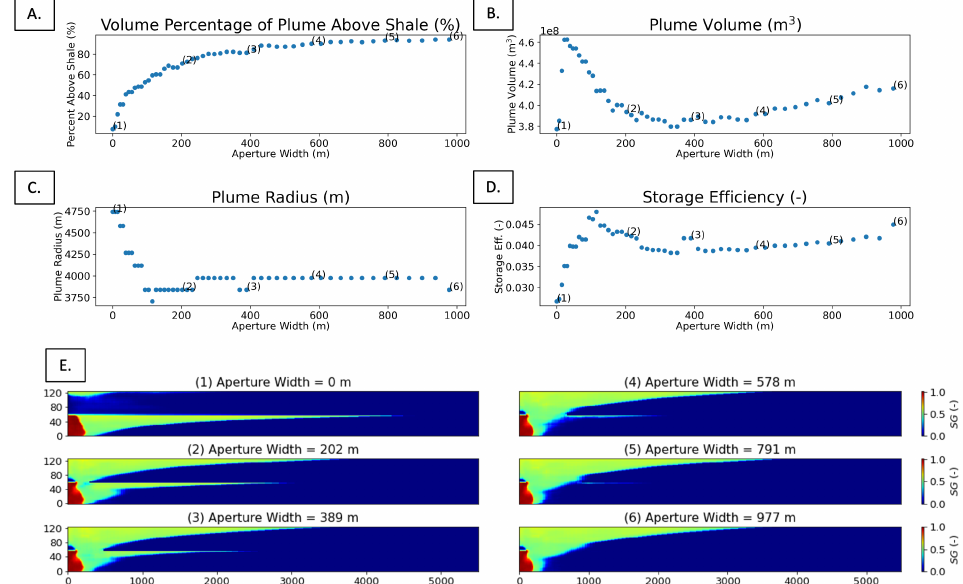
Figure 8. The impact of the aperture width on plume migration. The first four plots ( A – D ) illustrate the relationship between four plume variables and the shale length. The bottom six plots (( E )) show the gas saturation map of six modeled cases (labeled in the above plots).